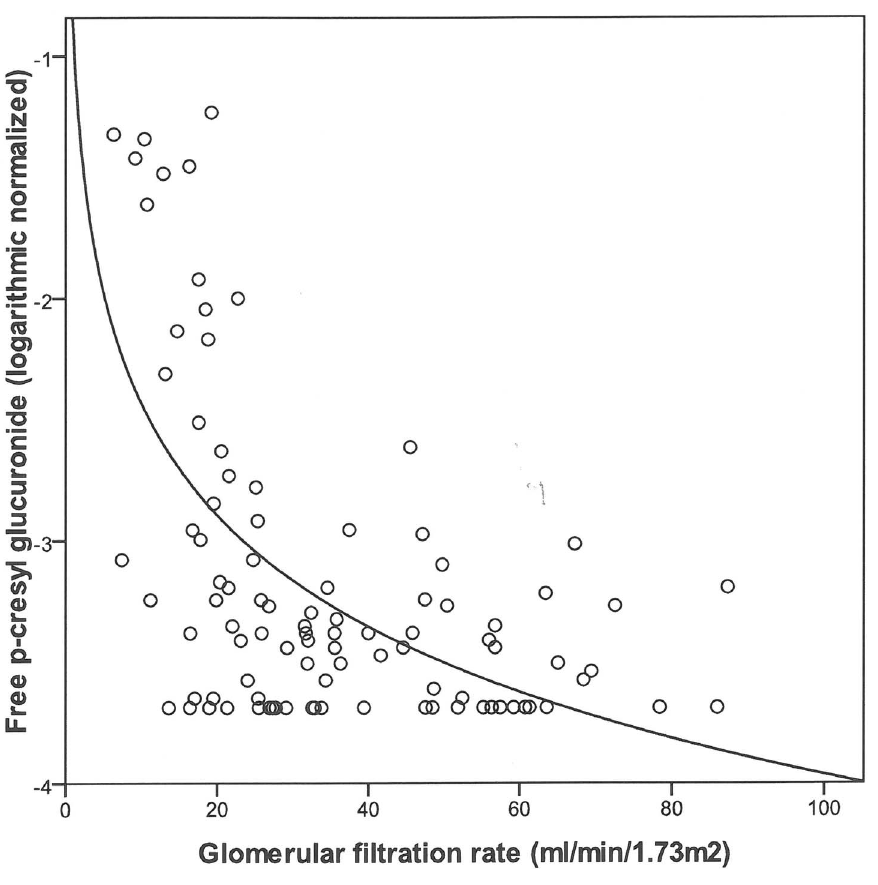
Figure 2 . Logarithmic regression curves. The relationship between log-normalized free p-cresylglucuronide serum levels and the estimated glomerular filtration rate for patients at CKD stages 2 to 5; r 2 =0.34, p , 0.0001 (n=96).